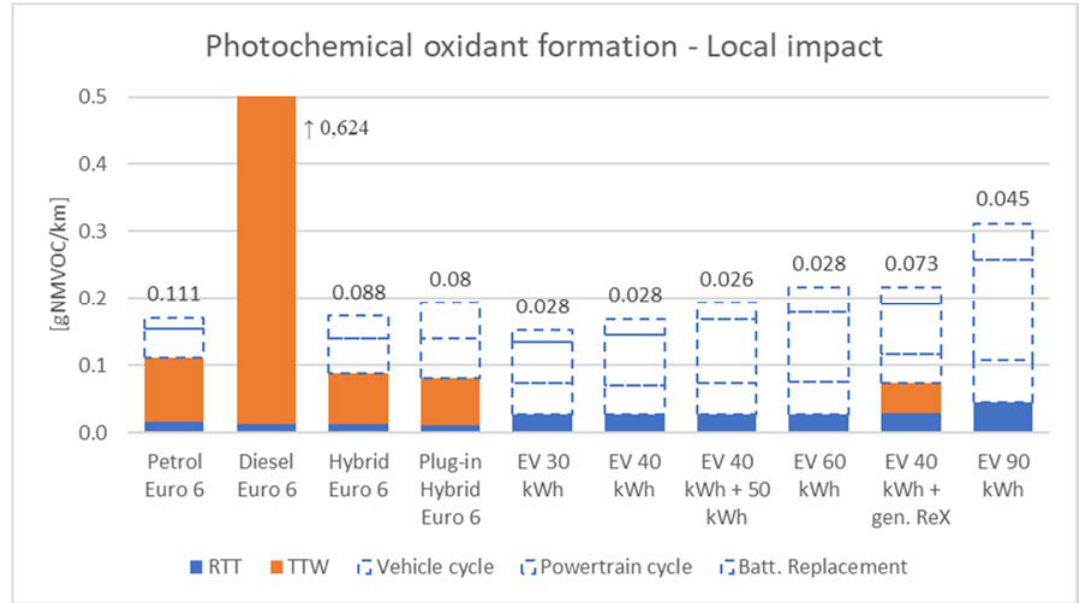
Figure 6. Photochemical oxidant formation at a local level per powertrain technology.